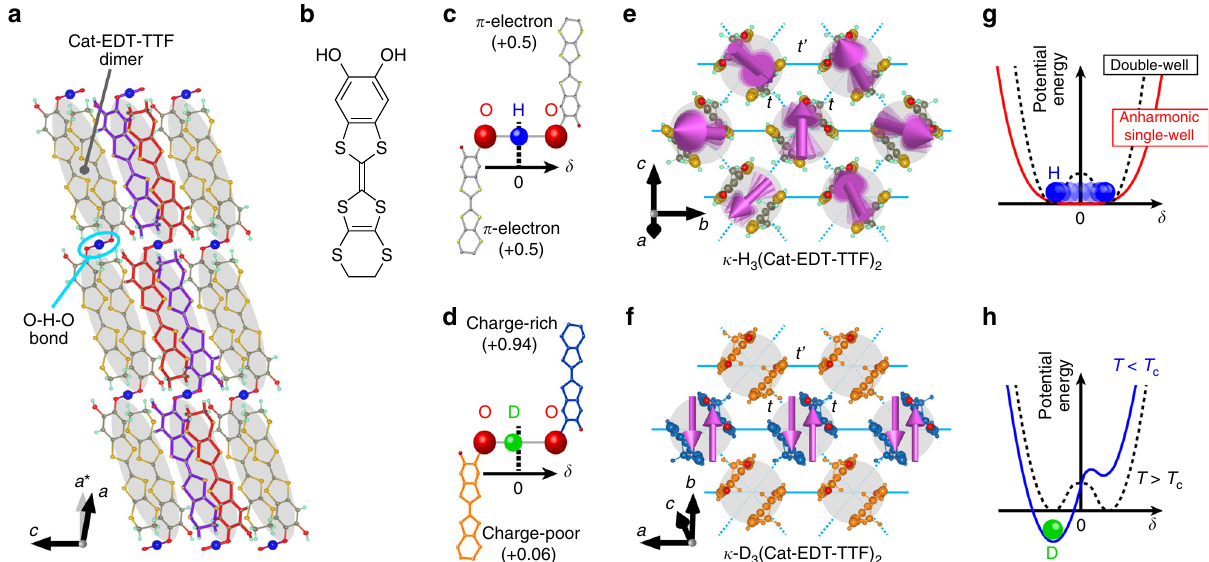
Fig. 1 Crystal structures of H-Cat and D-Cat. a Crystal structure of H-Cat viewed along the b axis. b Molecular structure of H 2 Cat-EDT-TTF. c Hydrogen- bonded molecular unit H 3 (Cat-EDT-TTF) 2 (supramolecule) in H-Cat. The supramolecules are formed by two [H(Cat-EDT-TTF)] 0.5+ molecules connected by the hydrogen bond. The supramolecules are stacked along the ( a + c ) direction, as shown in a . For clarity, a part of the stacking columns is colored red and purple in a . In the b – c plane, two face-to-face [H(Cat-EDT-TTF)] 0.5+ molecules form a strongly dimerized unit (gray ellipsoid), which generates the 2D π -electron layers connected by the O – H – O hydrogen bonds (light blue circle). d Supramolecular unit in D δ in c , d denotes the 3 (Cat-EDT-TTF) 2 . Note that displacement of the hydrogen and deuterium atoms from the center of the O – H – O and O – D – O bonds, respectively. e Spin and charge structures of the 2D π -electron layer in H-Cat. The π -dimers form a slightly anisotropic triangular lattice with S = 1/2 spins (magenta arrows). Dotted and solid lines show the inter-dimer hopping integrals, t and t ′ , respectively. f Spin and charge structures of a 2D π -electron layer in D-Cat below the phase transition temperature T c of 185 K. Charge disproportionation associated with deuterium localization leads to a non-magnetic ground state below T c . The blue- and orange-colored dimers indicate the charge-rich (+0.94) and charge-poor (+0.06) sites, respectively 21 . g , h Schematics of the potential energy curves of the hydrogen atoms in H-Cat ( g) and the deuterium atoms in D-Cat ( h) . In H-Cat, the potential energy curve is suggested to change from a double-well structure (dashed line) to a very shallow and anharmonic single-well structure (red solid line) owing to the many-body effect arising from the network of hydrogen bonds and π -electrons 22,23 . In sharp contrast, the energy curve in D-Cat retains a double-well structure above T c = 185 K (dashed line), leading to the deuterium localization at T c (blue solid